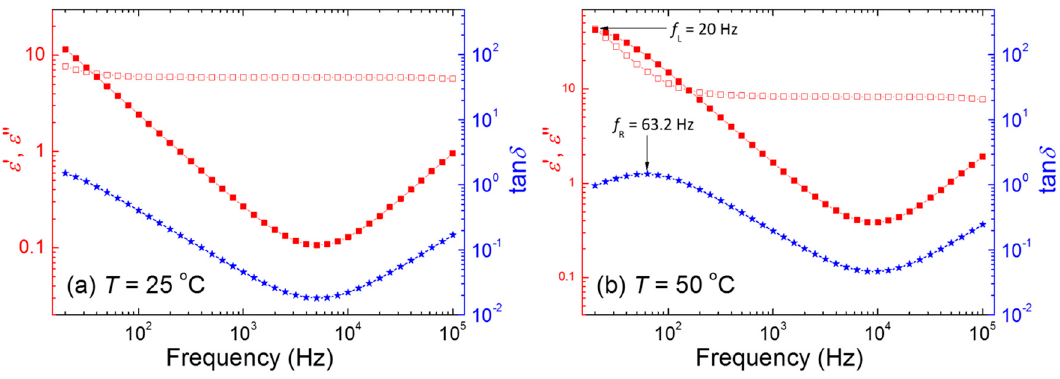
Figure 6. Complex dielectric and loss-tangent (tan δ ) spectra of the CLC cell in the P state at temperatures of ( a ) T = 25 ° C and ( b ) T = 50 ° C.